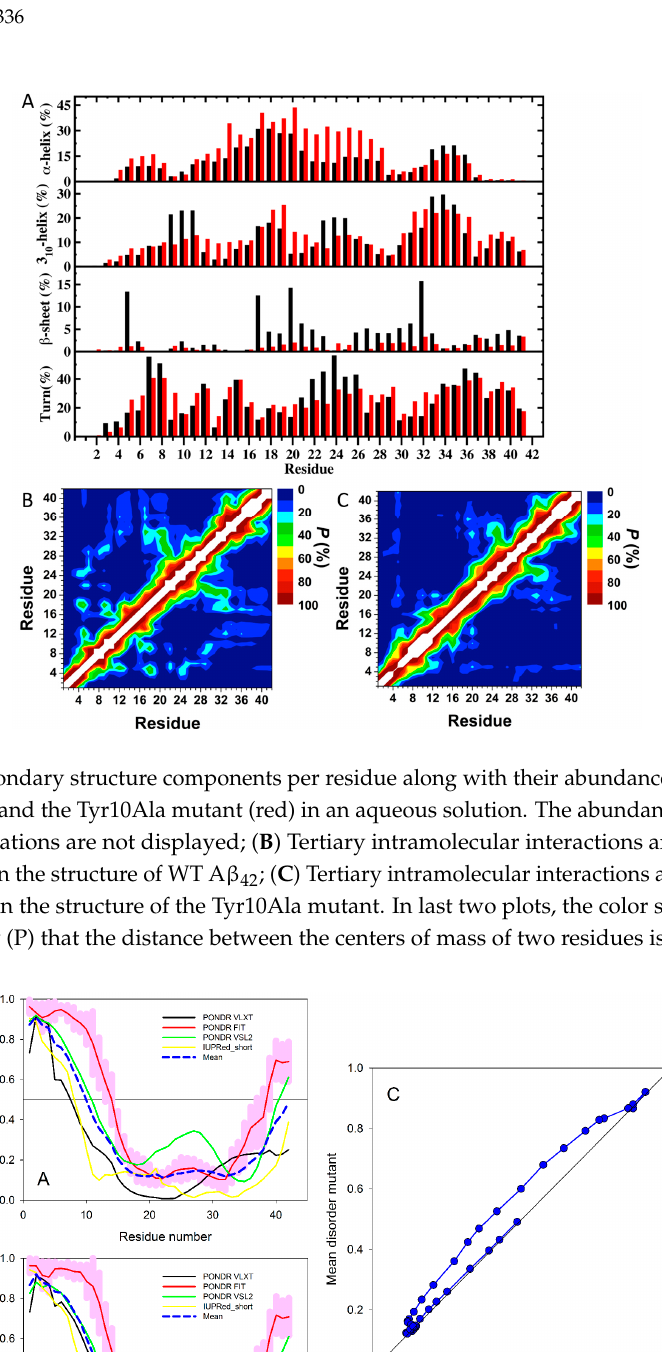
Figure 6. Secondary structure transitions between two specific secondary structure components per residue for ( A ) WT A β 42 and ( B ) the Tyr10Ala mutant in an aqueous solution medium. The color scale corresponds to the free energy values associated with specific transitions between two secondary structure components for a specific residue. Vu and co-authors investigated the structural change of the 3 A β 11–40 upon F19W mutation over 400 ns in temperature REMD simulations with 48 replicas [326]. They calculated the free energy values using the MM/PBSA method (see above). Their results showed that the secondary structure terms slightly change upon F19W mutation, since mutant showed 3% less β -sheet and 3% more coil contents. In addition, the number of contacts, SASA and radius of gyration values changed only slightly upon F19W mutation. However, RMSD values showed an increase caused by the F19W